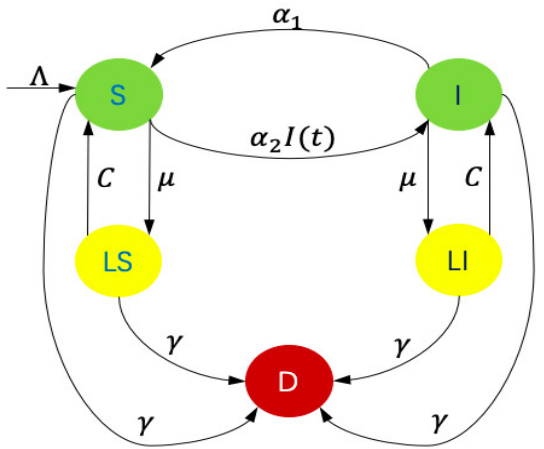
Figure 1. Flow diagram of the S usceptible, I nfected, L ow-energy, S usceptible (SILS)